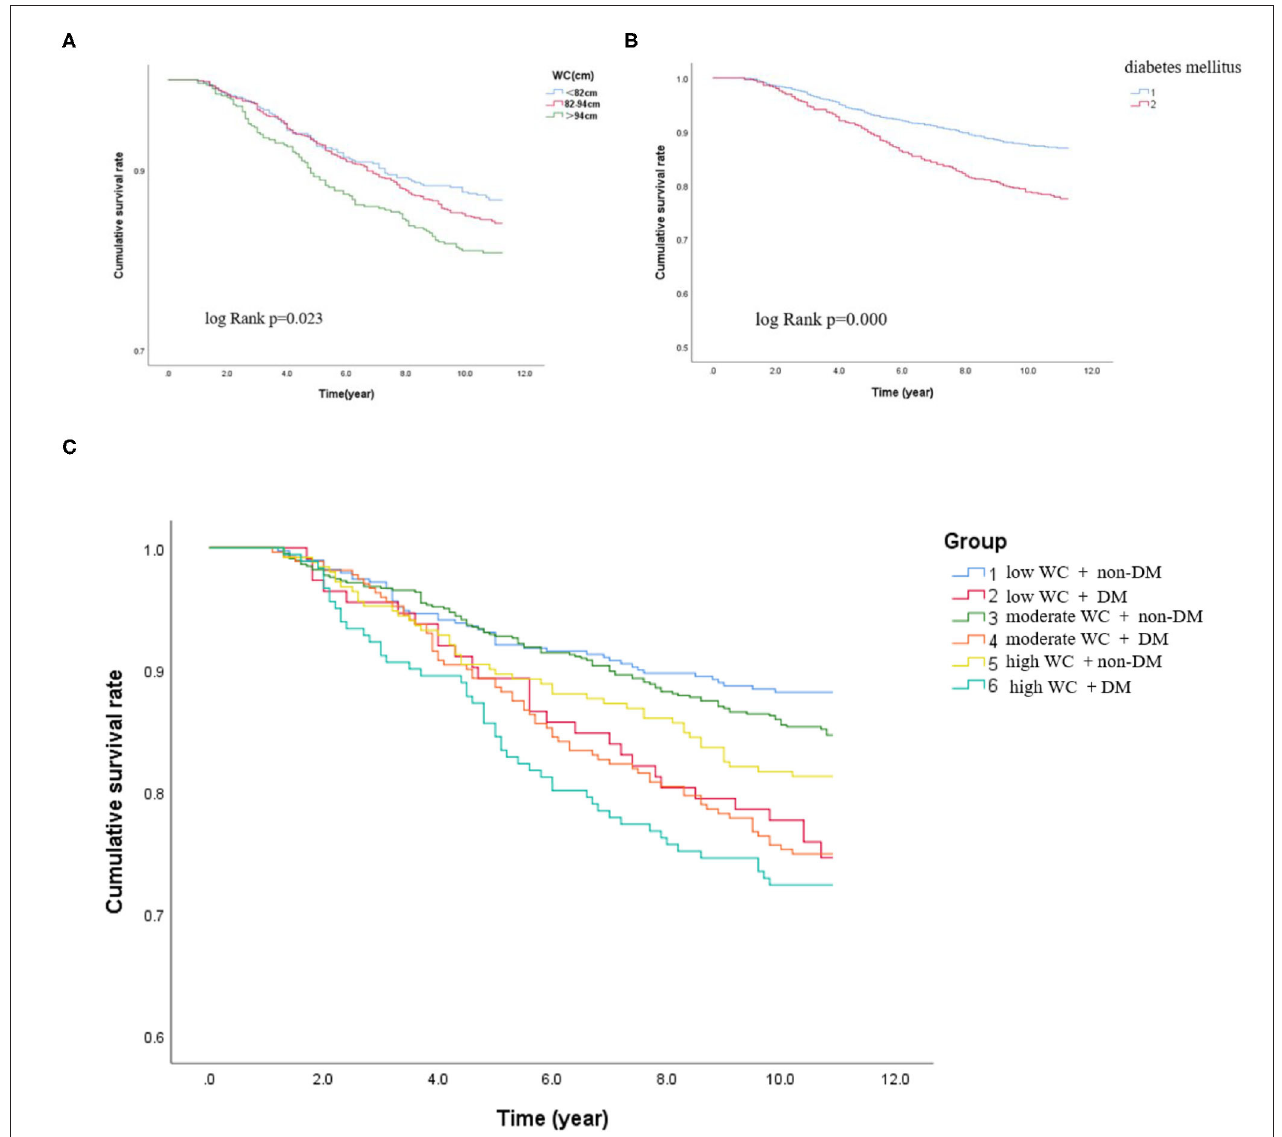
FIGURE 2 | Kaplan–Meier curves in different subgroups. (A) Kaplan–Meier survival rate of the participants according to the different WC levels. (B) Kaplan–Meier survival rate of the participants with or without DM. (C) Kaplan–Meier survival rate of the participants with DM and non-DM according to different degrees of WC.